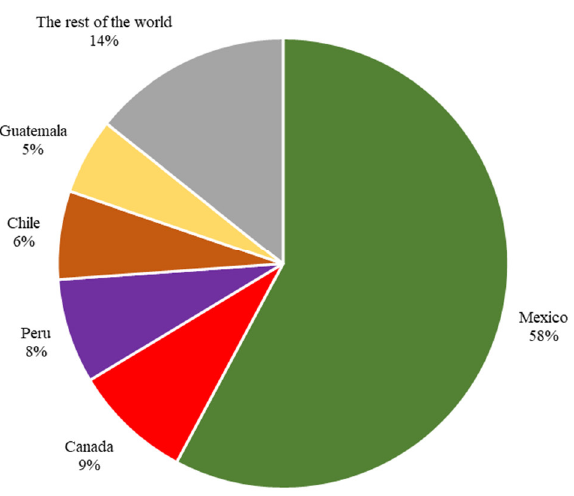
Figure 2. Top 5 U.S. fresh fruit and vegetables import origins in 2020. Source: USDA FAS [11] .